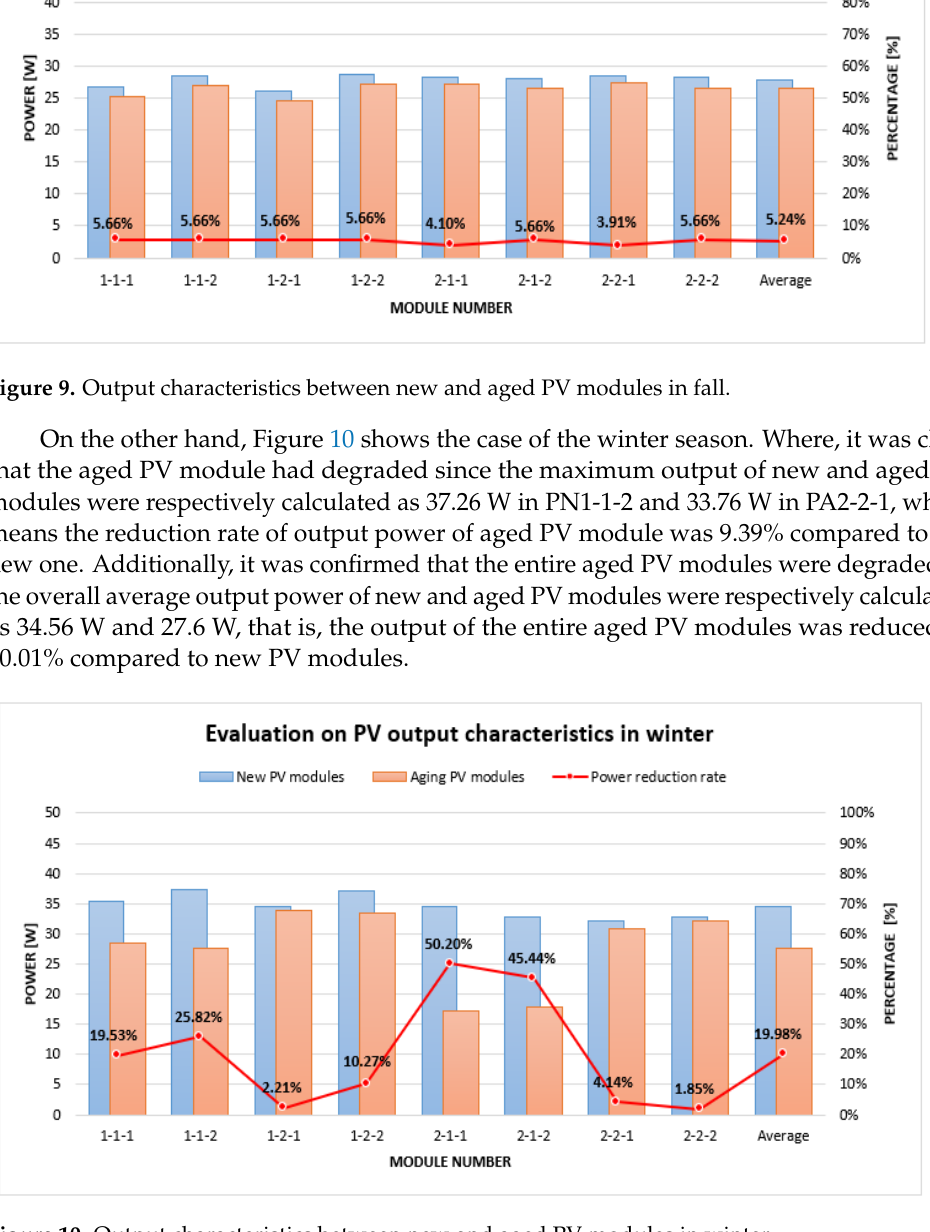
Figure 10. Output characteristics between new and aged PV modules in winter.